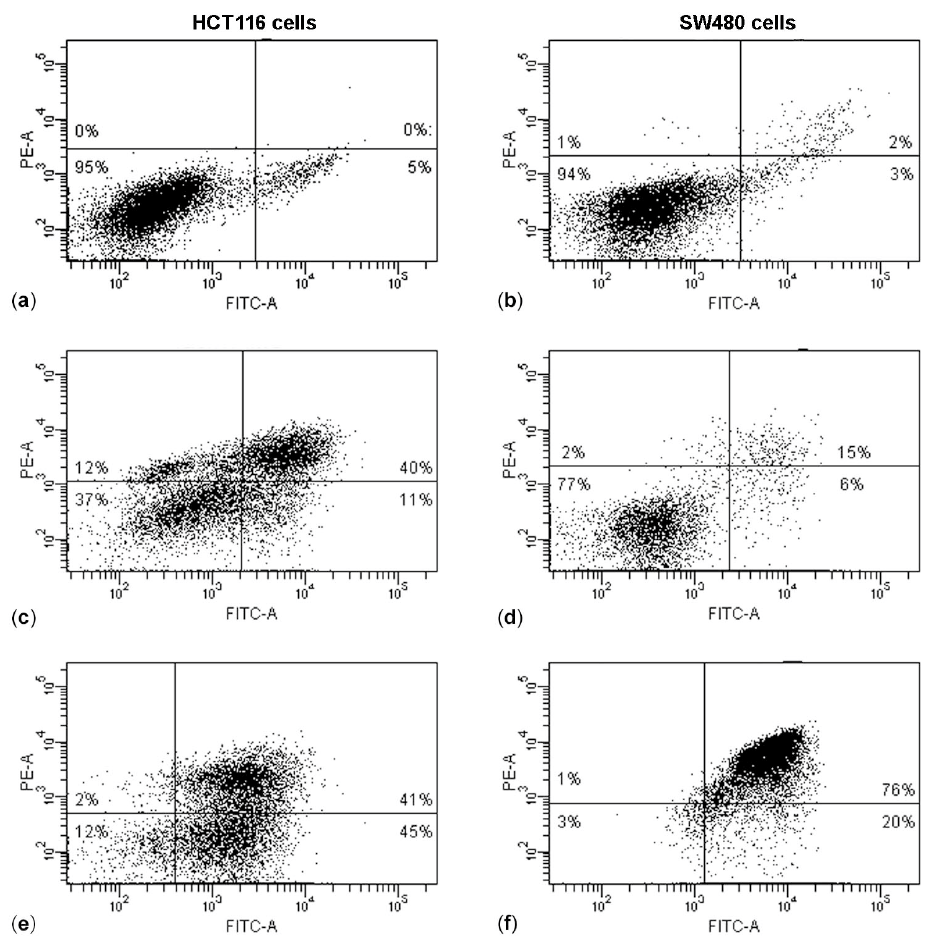
Figure 5. Apoptotic induction on HCT116 and SW480 cells performed by Annexin V-fluorescein isothiocyanate (FITC)/Propidium iodide (PI) test. HCT116 control cells ( a ) treated with (PsT 5 mg/mL + NAC) ® ; ( c ) (PsT 10 mg/mL + NAC) ® ; ( e ) for 24 h. SW480 control cells ( b ) treated with (PsT 5 mg/mL + NAC) ® ; ( d ) (PsT 10 mg/mL + NAC) ® , ( f ) for 24 h. Dot plots are representative of three independent experiments.